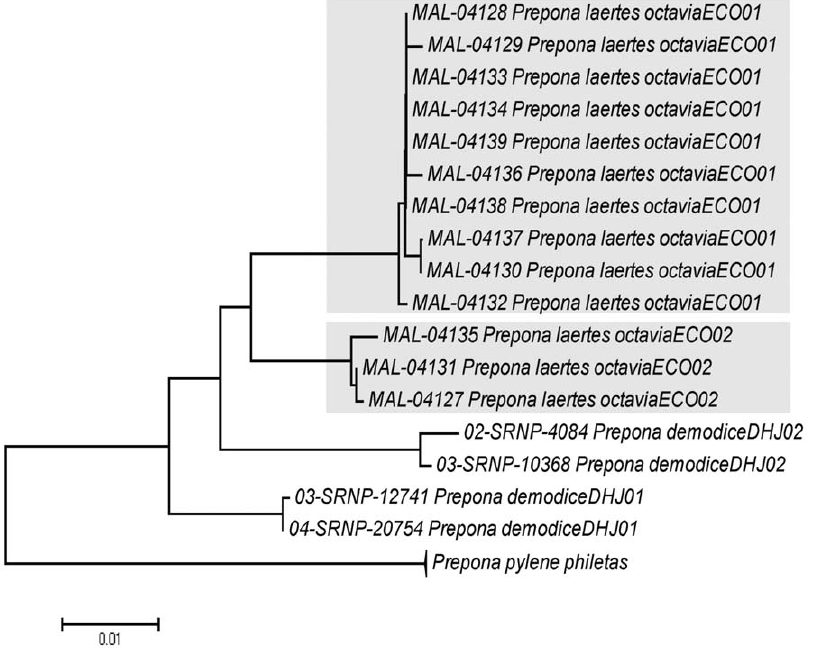
Figure 7. NJ tree showing species of Prepona from Yucatan Peninsula and Costa Rica. The two clusters of P. laertes octavia from the Yucatan are shown in grey. Note that similarly deep divergence was found in Costa Rican P. demodice . These two species were previously thought to be subspecies of Prepona laertes ( P. laertes octavia and P. laertes demodice ).